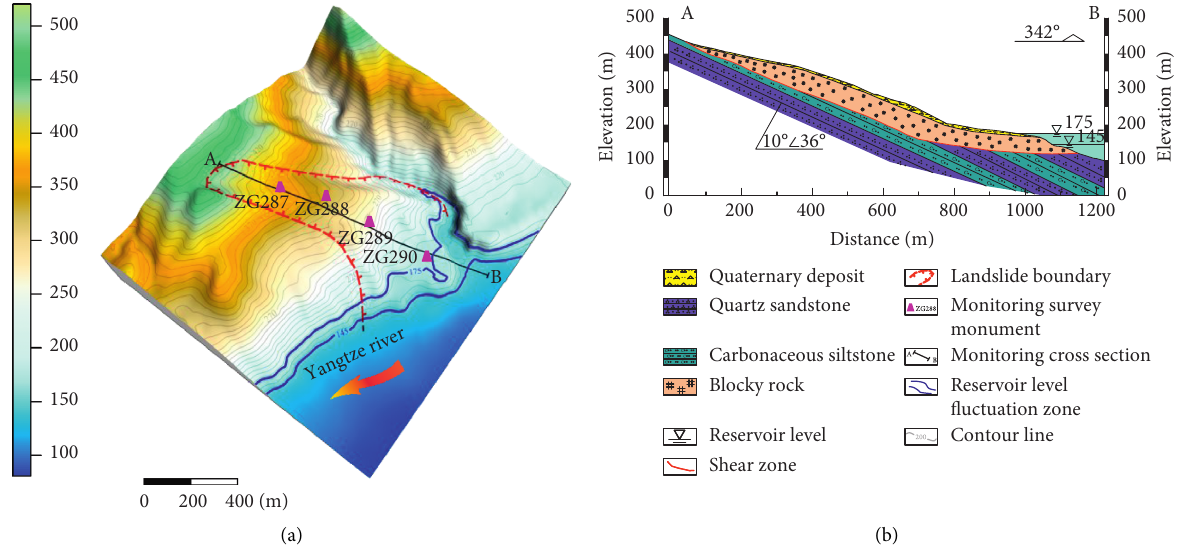
Figure 5: (a) Three-dimensional topographic contour map of the Tanjiahe landslide. (b) Engineering geological cross section (A-B) of the Tanjiahe